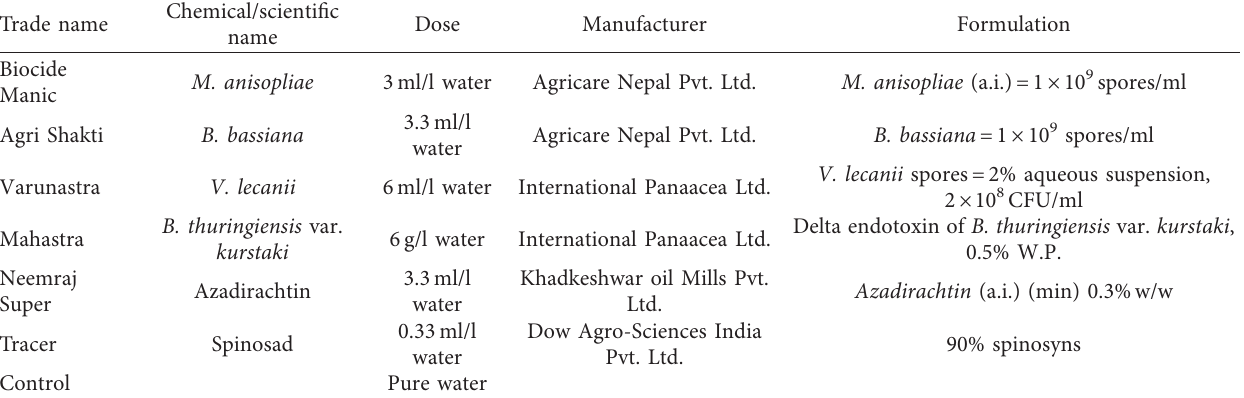
Table 1: Treatment